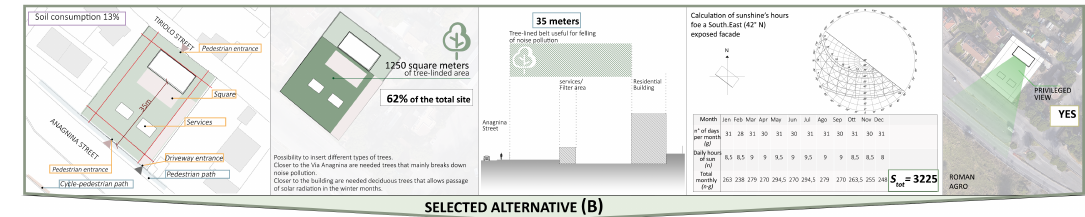
Figure 3. Optimal design configuration. (Source: Elaboration from E. Sonnino’s tables degree thesis